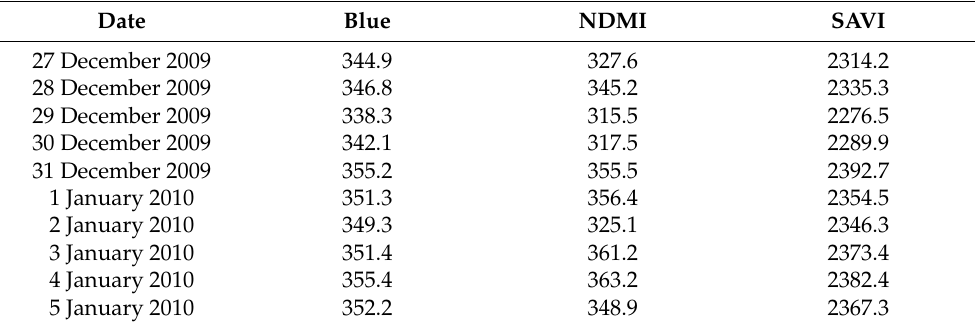
Table 1. Example of the aggregated dataset for each feature for each date. Note that the values are scaled by 10,000.